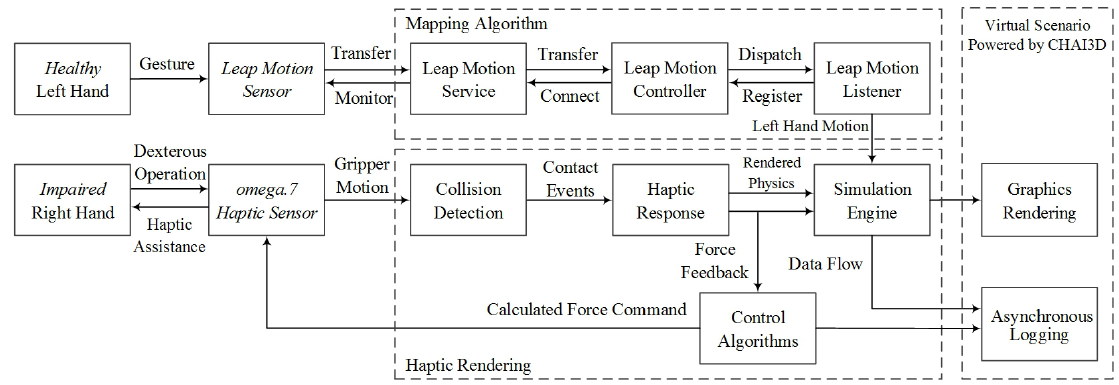
Figure 5. The fusion scheme for the gesture and haptic sensors and the supporting